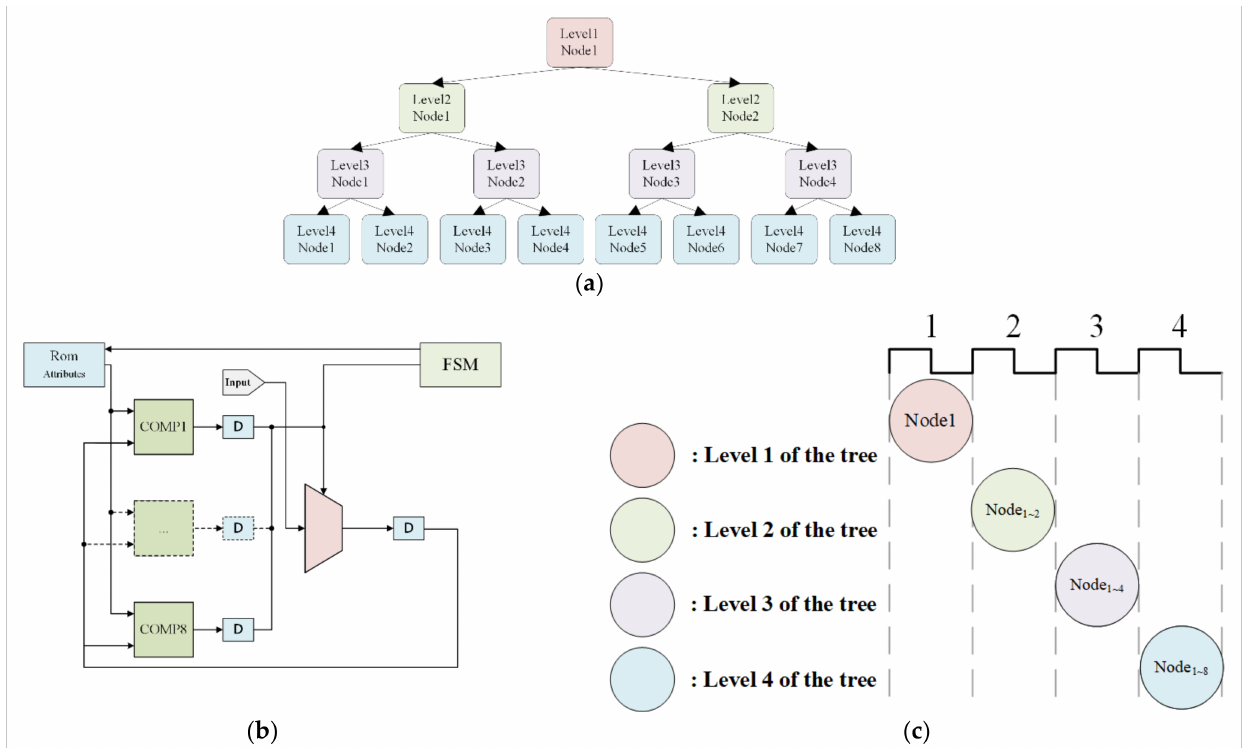
Figure 6. DT algorithm implementation. ( a ) The sample decision tree. ( b ) Block diagram of DT. ( c ) Scheduling of the DT processing.